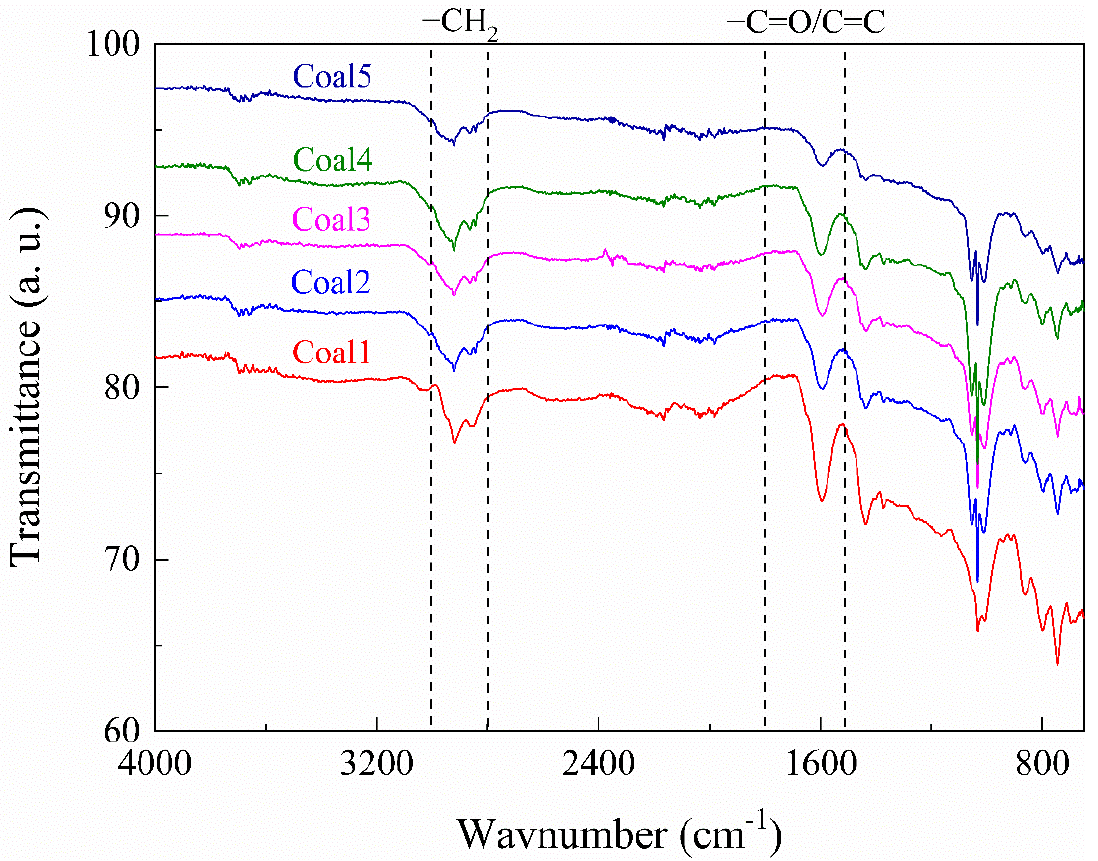
Figure 4. ATR-FTIR spectra of bituminous coal samples.